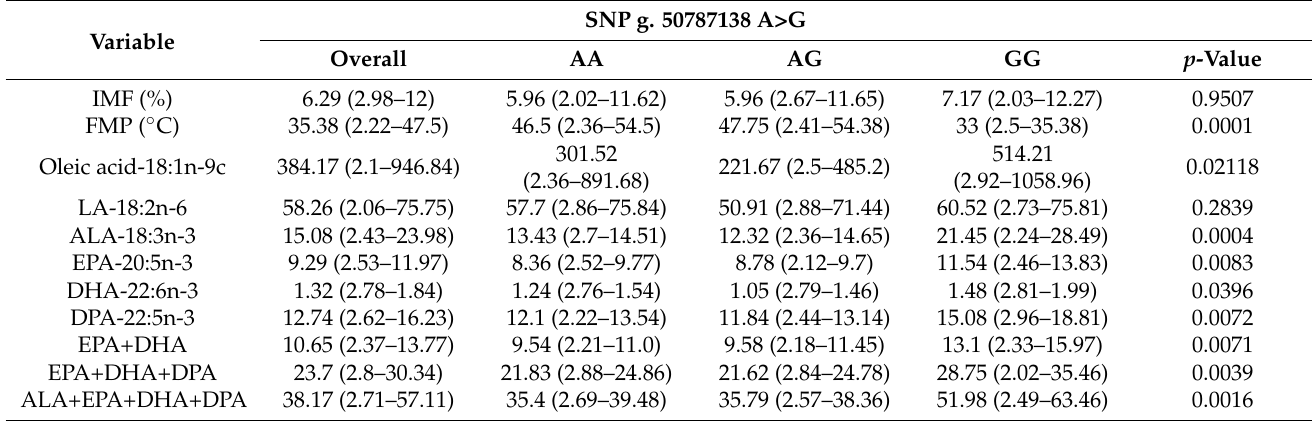
Table 7. Descriptive summaries of the associations between FASN SNP locus g. 50787138 A>G and genotypes with intramuscular fat (IMF), fat melting point (FMP), and fatty acid composition in Angus, Hereford, and Wagyu beef cattle breeds presented as median (inter-quartile